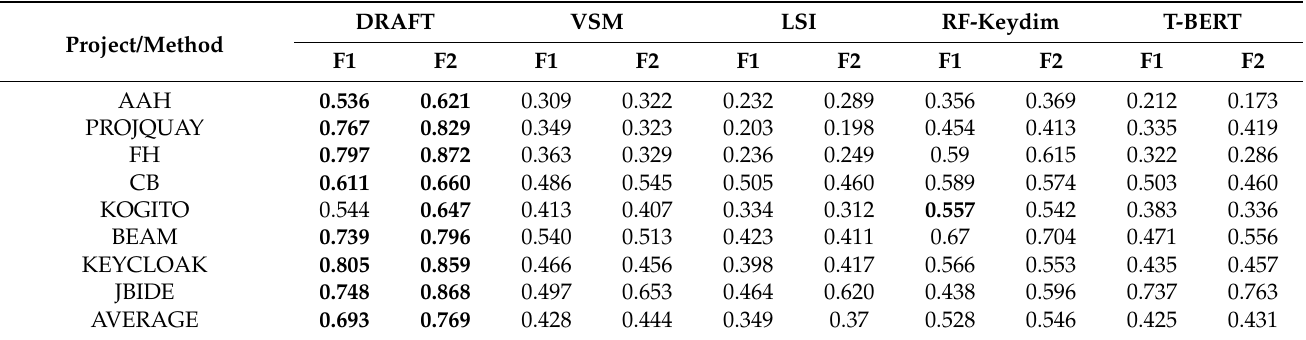
Table 4. Comparison of cross-level requirement trace link identification performance between DRAFT and baseline methods on eight datasets.